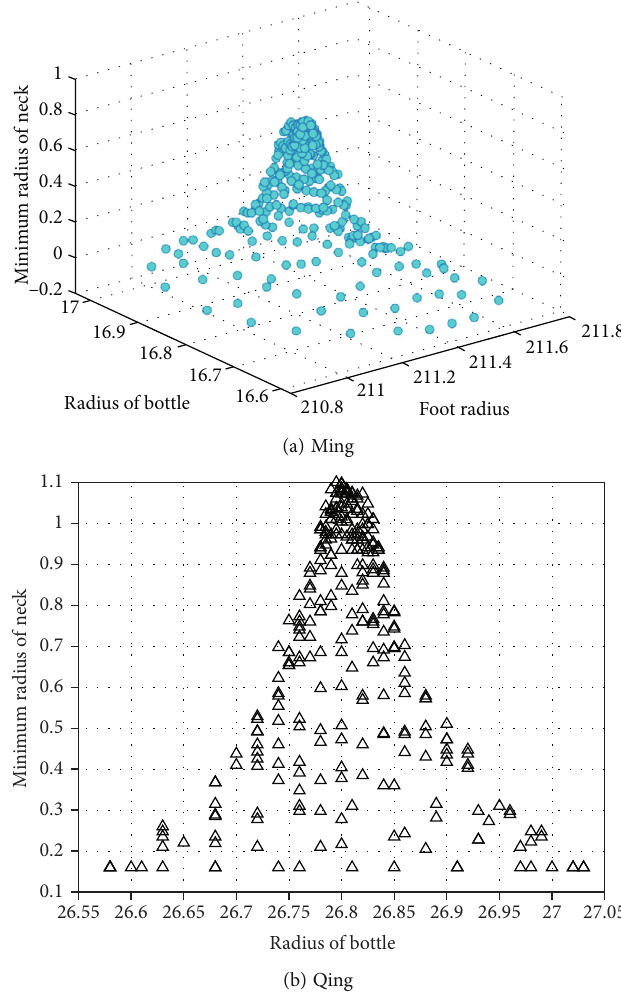
Figure 4: Scatter diagram of characteristic parameters of Yuquan bottles in Ming and Qing